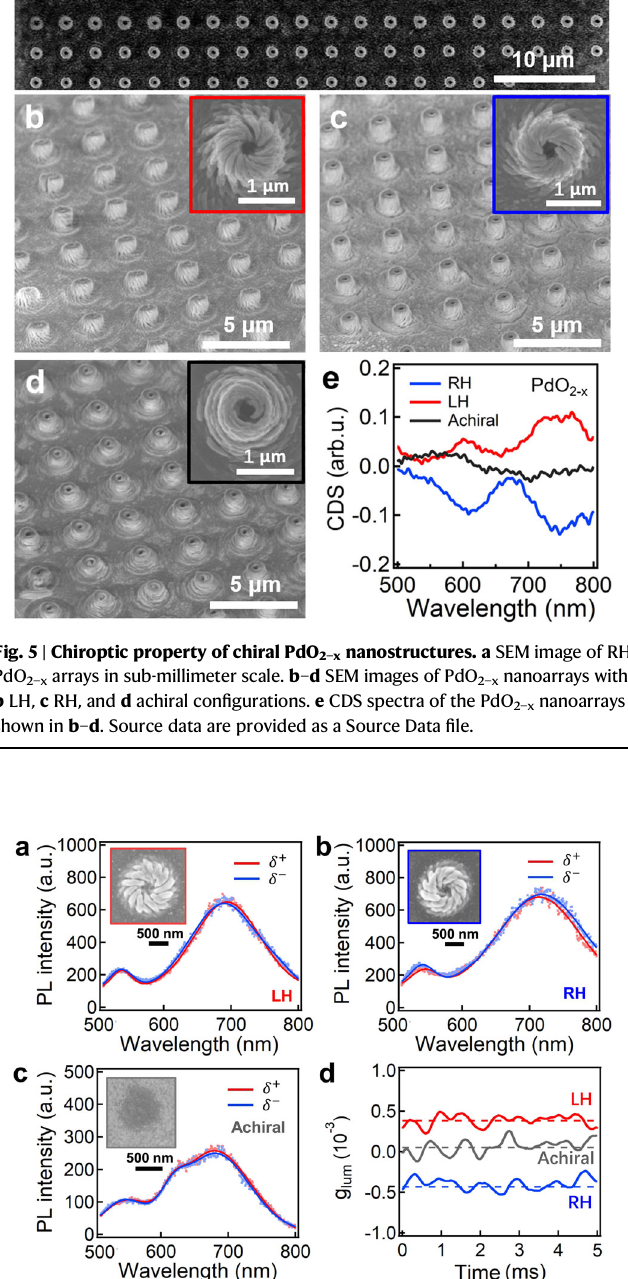
Fig.6|ChiralPLpropertyofchiralCdSnanostructures. ChiralPLspectraofCdS nanostructureswith a LH, b RHand c achiralcon fi gurations.Dotsaretherawdata and solid lines are fi tted data. Light (473nm) of LP was applied as the excitation source. δ + and δ − represent the detected signals with LCP and RCP waveplates, respectively.SEMinsetsrepresentthetypicalsamplesofenantiomersandachiral ones. d Chiral PL g -factor ( g lum ) of RH, LH and achiral nanostructures. Note the g lum of achiral CdS is normalized to zero. Source data are provided as a Source Data fi le.